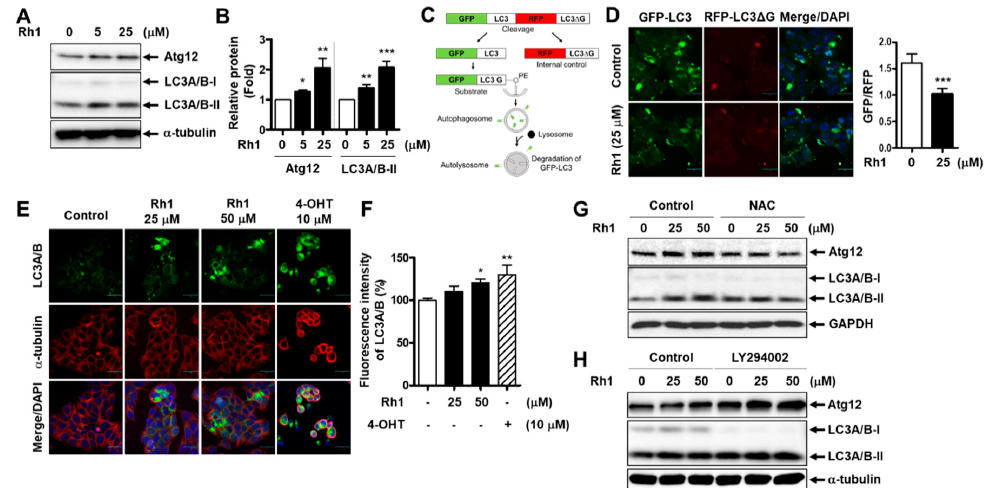
Figure 5. Rh1 induces autophagy in MCF-7 cells. ( A , B ) The cells were treated with Rh1 for 24 h. Total cell lysates were then analyzed using Western blotting ( A ). The relative quantification of protein levels was analyzed using Image J software ( B ). ( C ) The scheme presents the principle of the dual GFP/RFP-LC3 autophagy flux sensor system. ( D ) MCF-7 cells were transduced with pMRX-IP-GFP-LC3-RFP-LC3 Δ G retroviral vectors for 30 h and then treated with Rh1 (25 µM) for 14 h. The cells were then observed under a laser scanning confocal spectral microscope. Images are shown at ×200 magnification. Scale bar indicates 30 µm. The relative GFP/RFP ratio is represented as the mean ± SD ( n = 5). ** * p < 0.001 as compared with the control. ( E , F ) The cells were treated with Rh1 (25 and 50 µM) or 4-OHT (10 µM) for 24 h. An immunofluorescence analysis was performed after fixing and immunostaining. Images ( E ) are shown at ×200 magnification. Scale bar indicates 30 µm. The relative fluorescence intensity of LC3A/B ( F ) are represented as the mean ± SD ( n = 5), * p < 0.05 and * * p < 0.01 as compared with the control. ( G , H ) The cells were pretreated with 20-mM NAC ( G ) or 5-µM LY294002 ( H ) for 3 h, followed by the treatment with Rh1 for 24 h. Total cell lysates were subjected to Western blotting. 4-OHT: 4-hydroxytamoxifen, NAC: N-acetylcysteine, LY294002: PI3K inhibitor, GFP: green fluorescent protein, and RFP: red fluorescent protein.